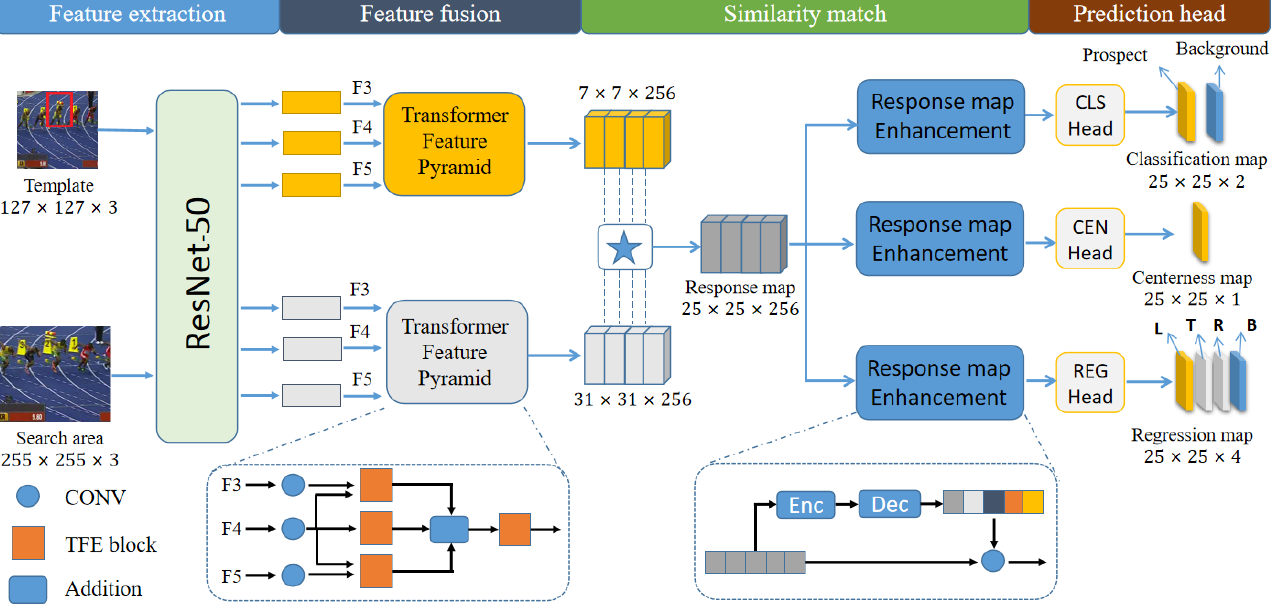
Figure 1. This is the schematic diagram of TR-Siam. The ☆ stands for cross-correlation operation. Template contains target of interest. Search area is centered on the template position and three times the size of the template in the detection frame.